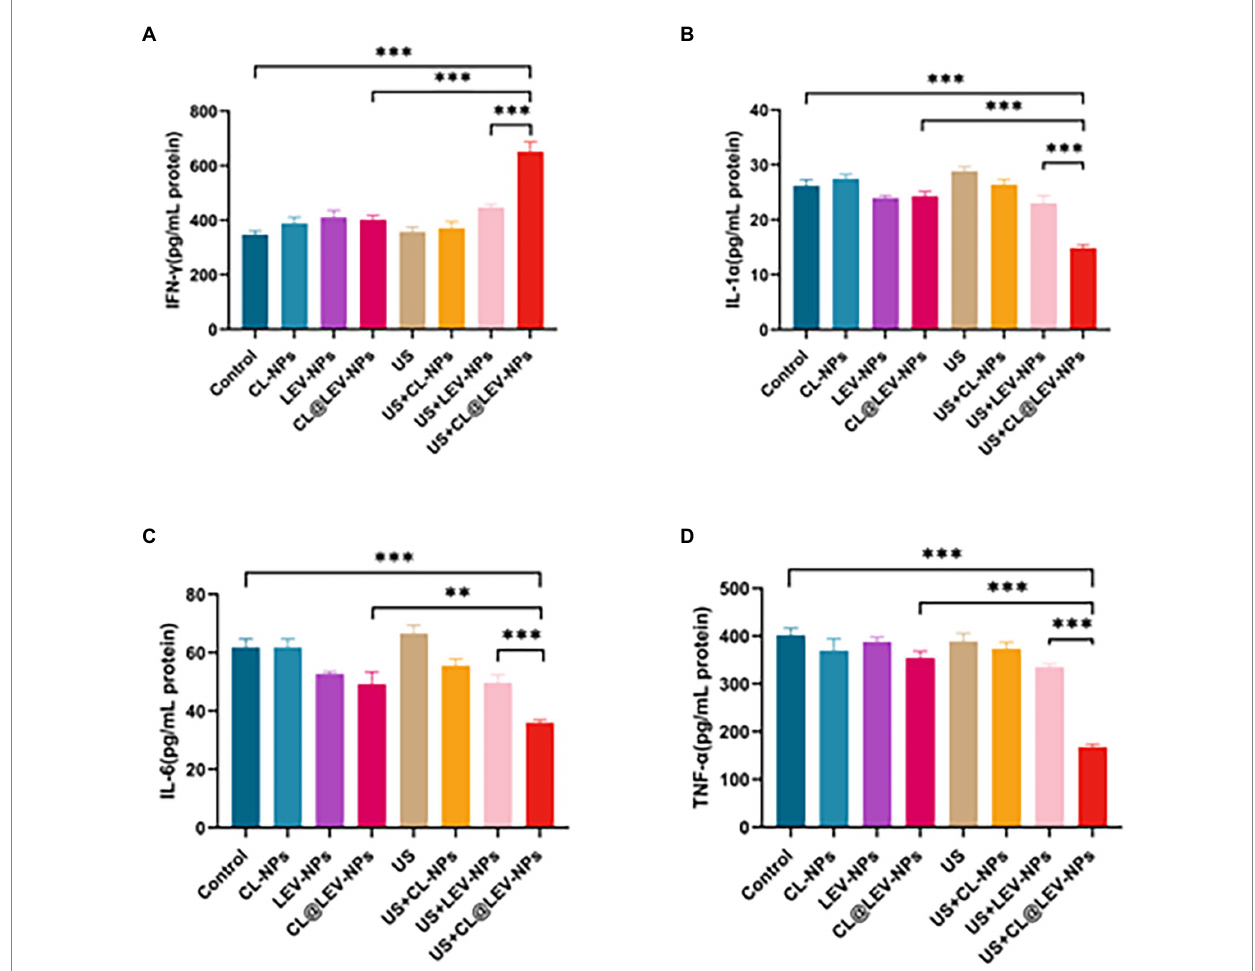
FIGURE 10 ELISA assay. The concentrations of IFN- γ (A) , IL-1 α (B) , IL-6 (C), and TNF- α (D) in the serum of BALB/c mice in each group were measured by ELISA after the treatment of different experimental groups,** p < 0.01, *** p <